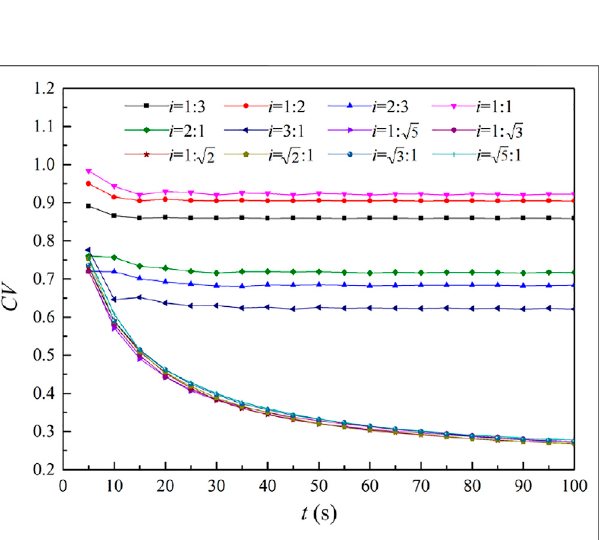
FIGURE 5 | Comparison of CV under different values of i